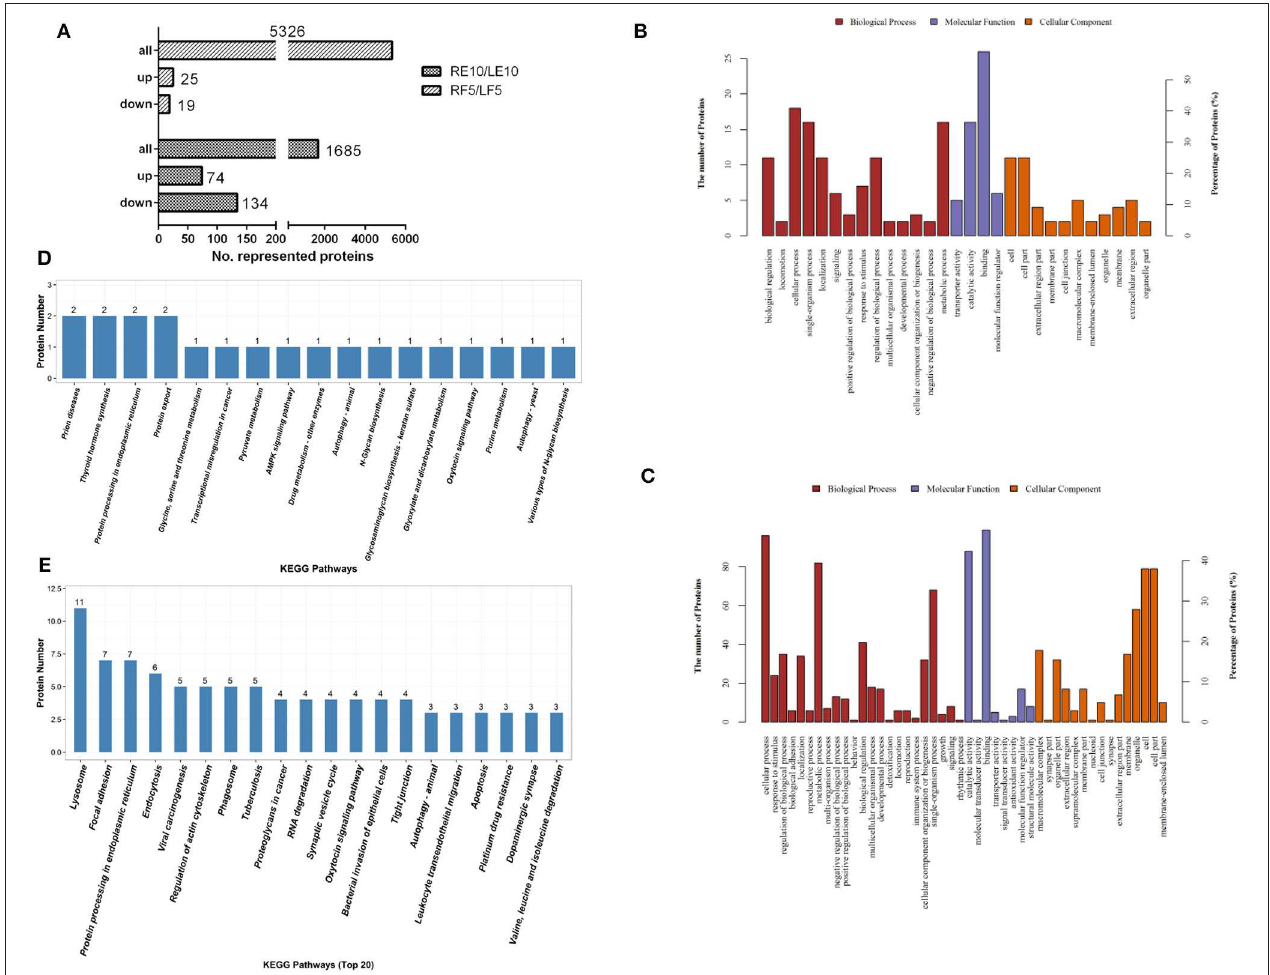
FIGURE 5 | Vitellogenin and HSP70 were expressed differentially in the ovary proteomic analyses. Twelve tick ovary samples were collected from RH36 or luciferase gene-silenced adult ticks at 5 days blood feeding and 10 days post-engorgement and analyzed using TMT technology. Number of total proteins and differentially-expressed proteins were obtained from ovary samples of adult ticks (A) . Differentially expressed proteins mainly involved in cellular process, developmental process and metabolic process with function of lipid transporter activity, catalytic activity and binding in the 5-day-fed tick ovaries (B) and 10-day post-engorged tick ovaries (C) by GO analysis, in which vitellogenin and HSP70 involved in protein export and protein processing in endoplasmic reticulum using KEGG enrichment analysis, respectively (D) . Differentially expressed proteins in the 10-day post-engorged tick ovaries chiefly participate in focal adhesion, endocytosis and protein processing in endoplasmic reticulum using KEGG enrichment analysis (E) .